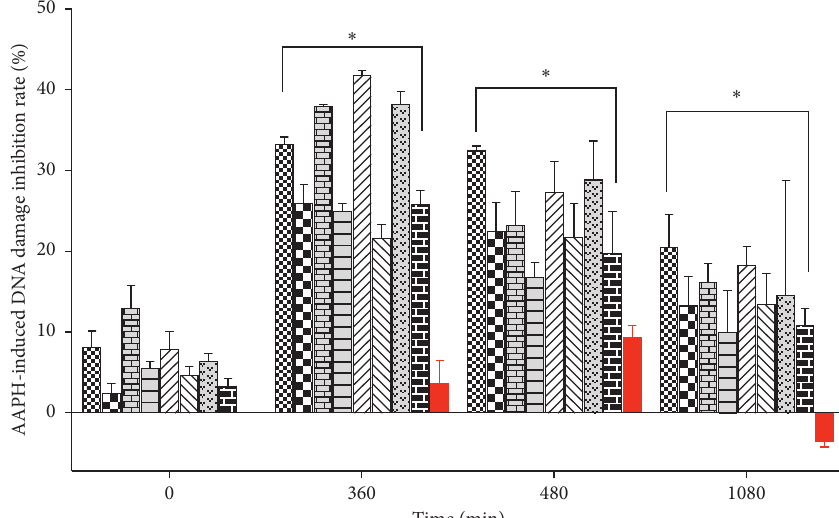
Figure 5: Inhibition effect of piperine derivatives on AAPH-induced oxidative damage in DNA: 5a 160 μ M ( ); 5a 80 μ M ( ); 5b 160 μ M ( ); 5b 80 μ M ( ); 5c 160 μ M ( ); 5c 80 μ M ( ); 5d 160 μ M ( ); 5d 80 μ M ( ); piperine 80 μ M ( ). ∗ indicates a significant difference from the piperine group ( p < 0 .